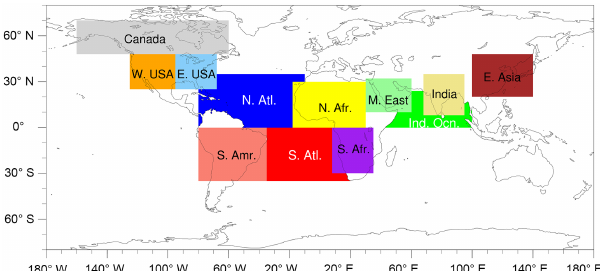
Figure 3. Map of 12 global zones selected for aerosol analysis be- tween NGACv2, MODIS and ICAP. Details about each zone are described in Table